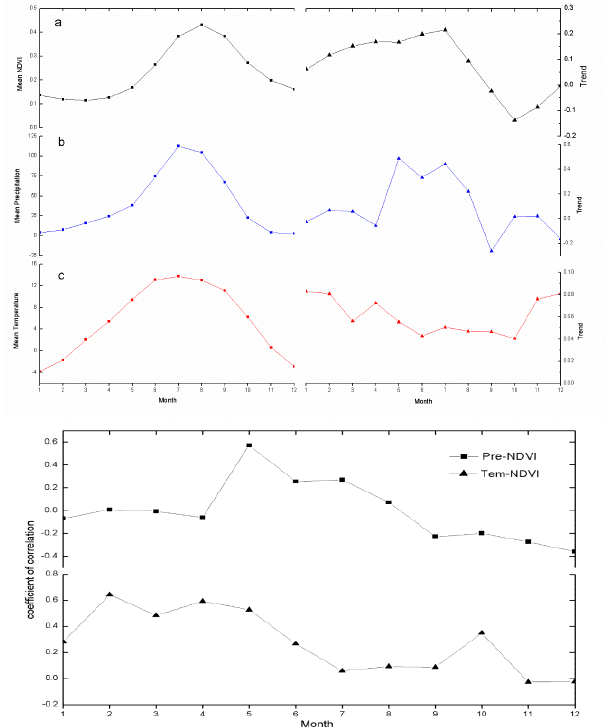
Figure 6. Seasonal changes in monthly NDVI and climatic variables from 1982 to 201 in the Yarlung Zangbo River. (a) 32-Year averaged monthly NDVI and its trend; (b) 32-year averaged monthly mean temperature and its trend; (c) 32-year averaged monthly precipitation and its trend; (d) correlations between monthly NDVI and temperature and